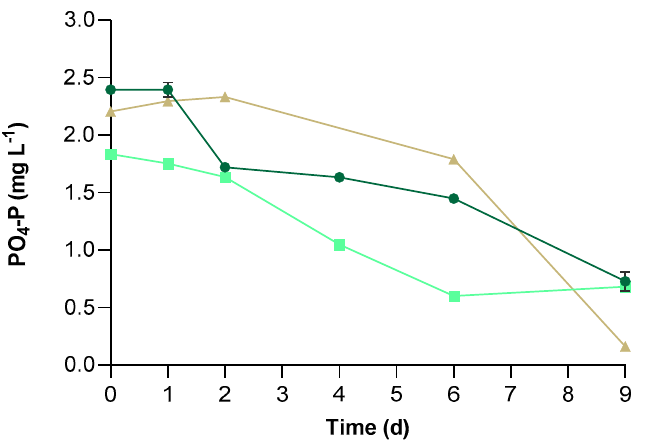
Figure 5. Variation of phosphate–phosphorus (PO 4 –P) concentration (average ± standard deviation) over time (d), expressed in mg L − 1 , for each PBR: (cid:4) CV ( C. vulgaris + UWW); (cid:4) C+ ( C. vulgaris + autoclaved UWW); and (cid:4) C − (raw UWW).